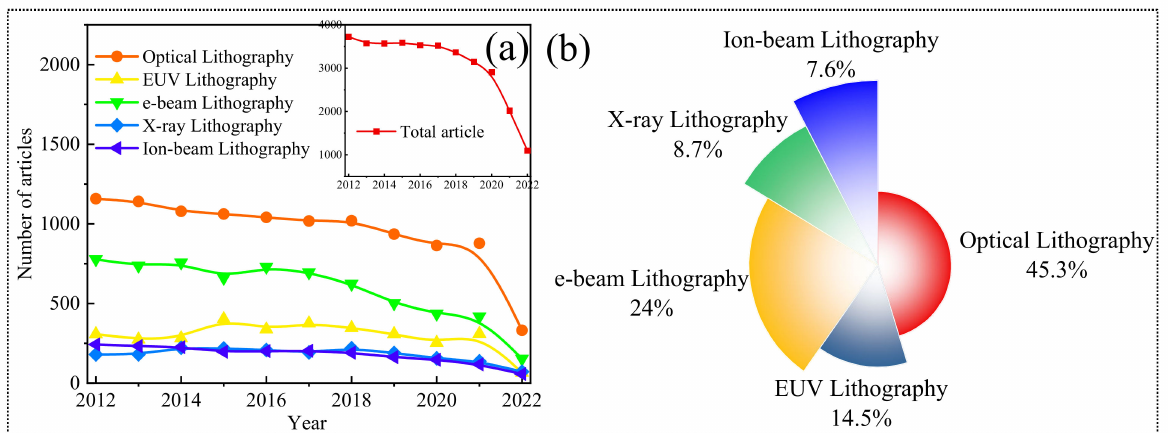
Figure 1. ( a ) Trends in lithography and its various techniques and ( b ) comparison of work done on different lithography techniques in the last five years [Data source: